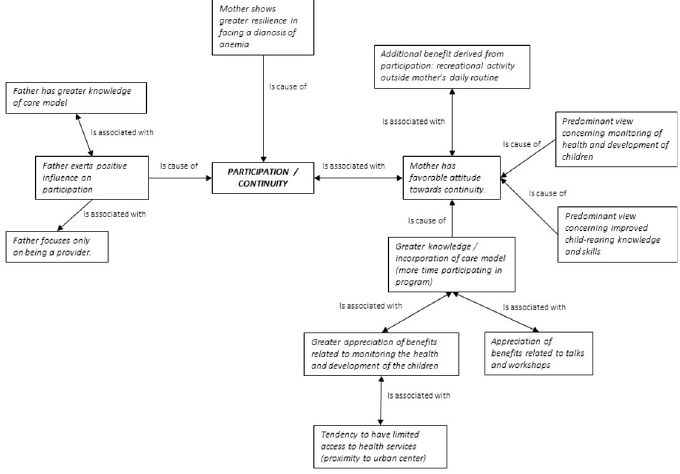
Fig 3. Factors related to participation / continuity in the ECD programs, Oaxaca, 2019. Source : Elaborated by the author using Atlas-Ti, V7 software [56].